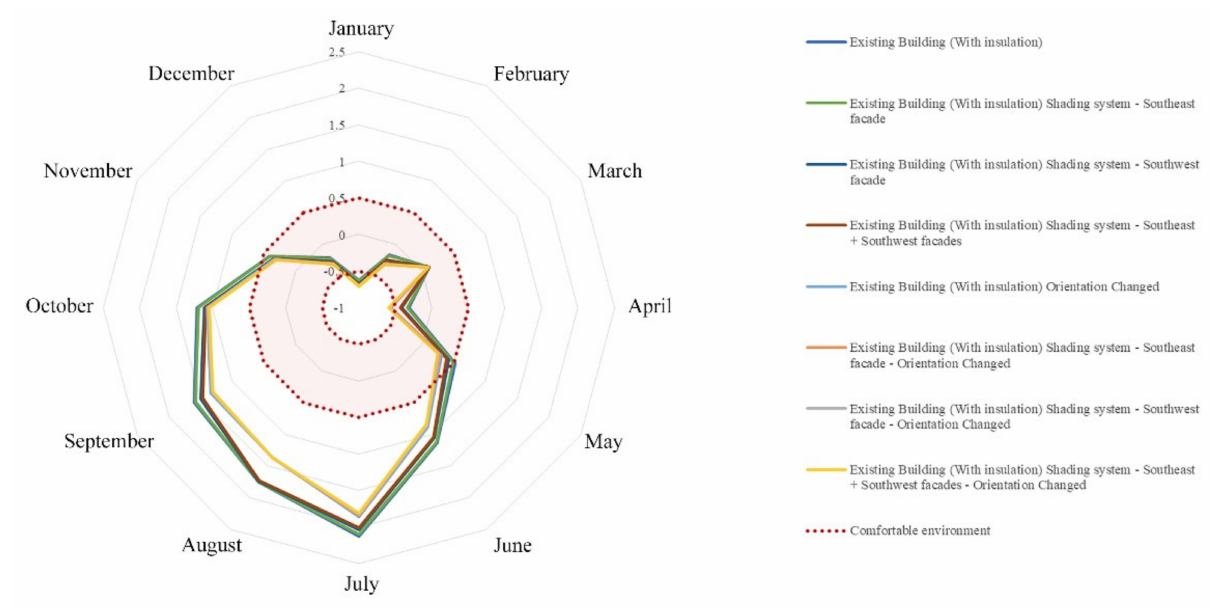
Figure 19. Monthly average calculation: predicted mean vote (PMV)—scenarios with